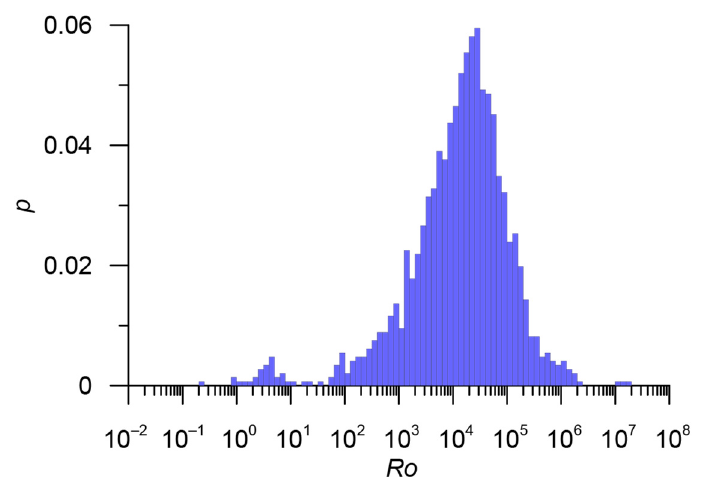
Figure 6. Metric distributions for the YAK_NER and KAM pairs.